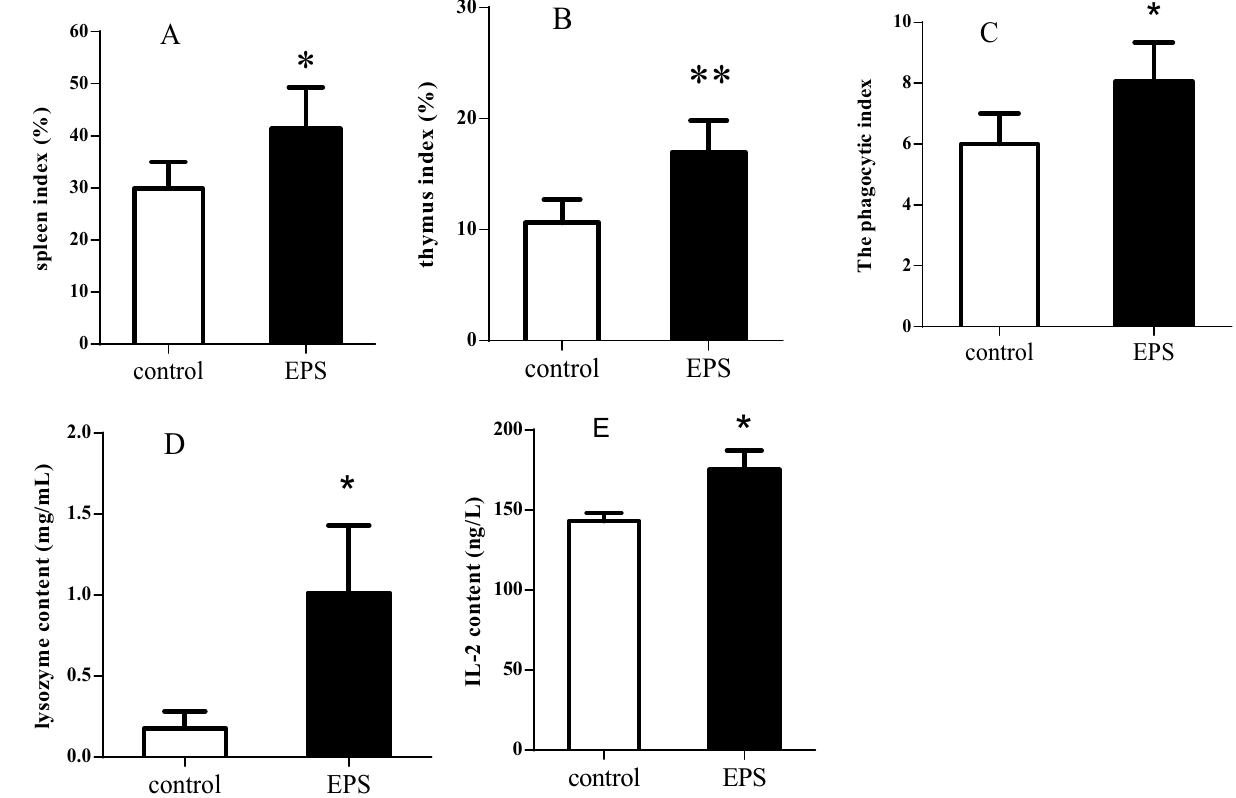
Figure 5. Immune-strengthening activities of EPS from Bacillus subtilis xztubd1 on immune organ indices ( A , B ), phagocytic activity of macrophages ( C ), lysozyme activity in macrophages ( D ) and IL-2 content in serum ( E ). Data are expressed as the mean ± standard error (n = 6). *P < 0.05, **P < 0.01 versus